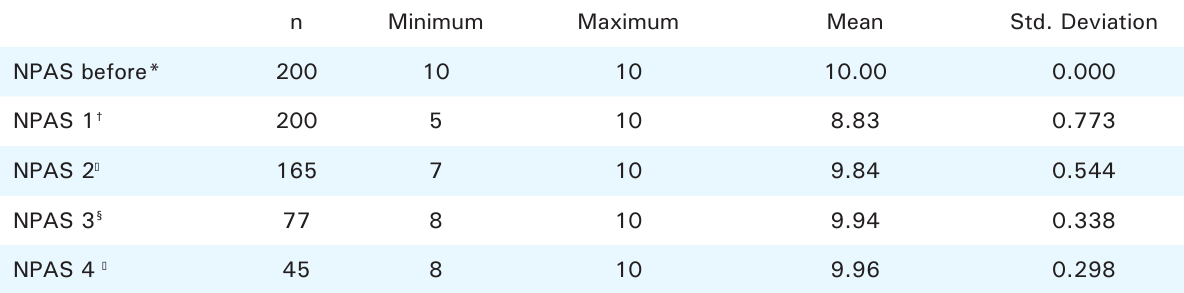
Table 2. Showing Numerical Pain Analogue Scale at different interval.